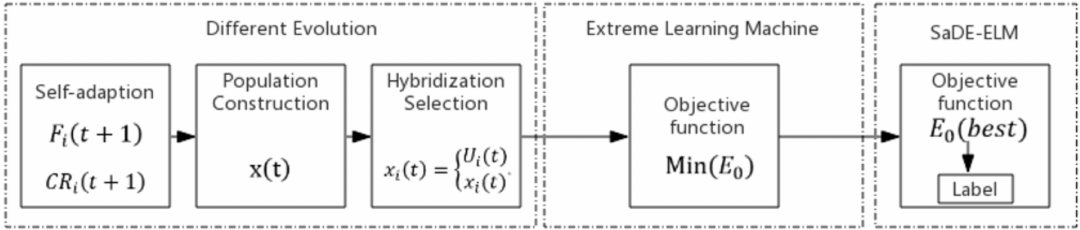
Figure 4. Flow chart of the Self-adaptive Different Evolution Optimized Extreme Learning Machine (SaDE-ELM)